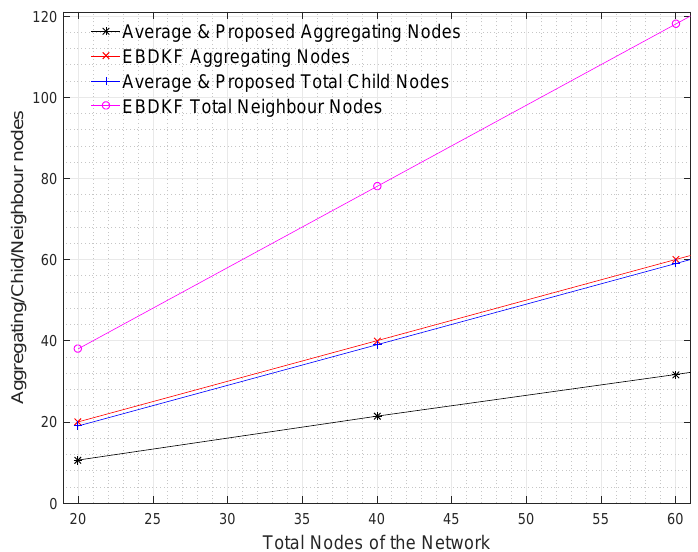
Figure 17. Average number of fusion nodes and total child nodes in tree-based IoT platform using maximum reliable connection method for different fusion